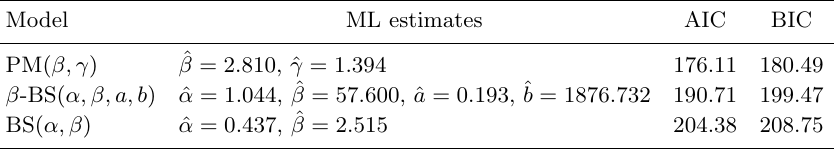
Table 2. Breaking stress of carbon fibres: Model, ML estimates, AIC and BIC values. Model